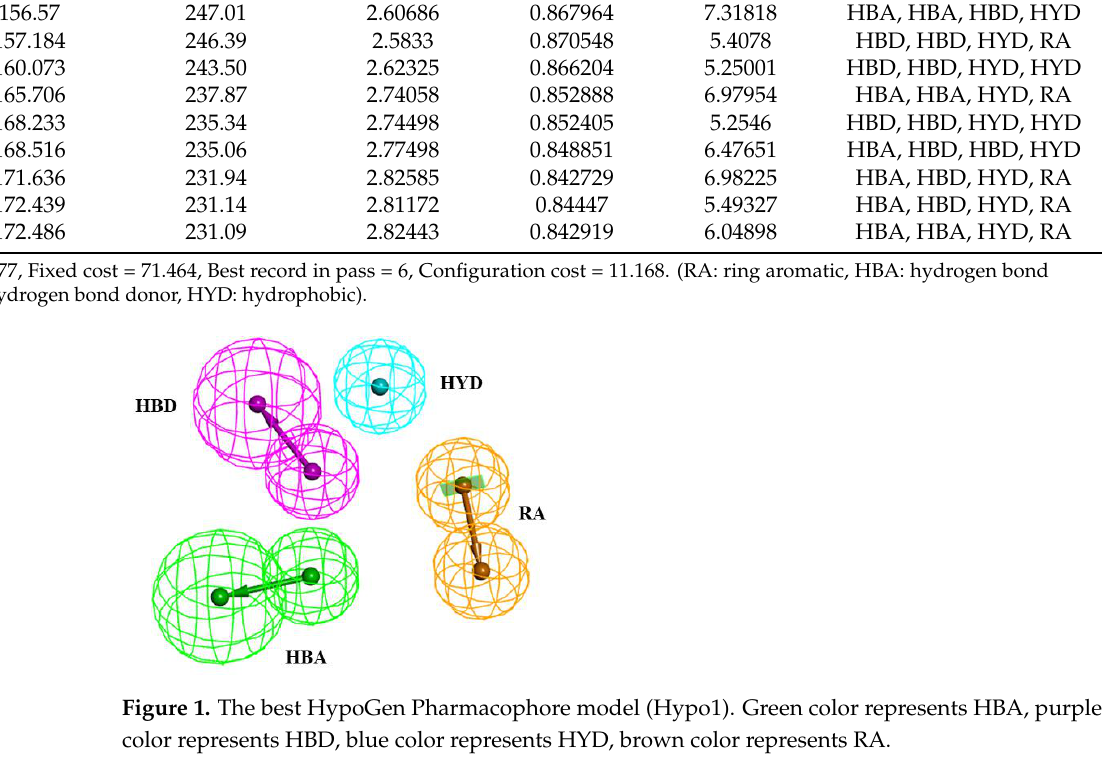
(IC 50 ) which were categorized in most active (≤0.1 μM, ++++), active (0.1 to 1.0 μM, +++),